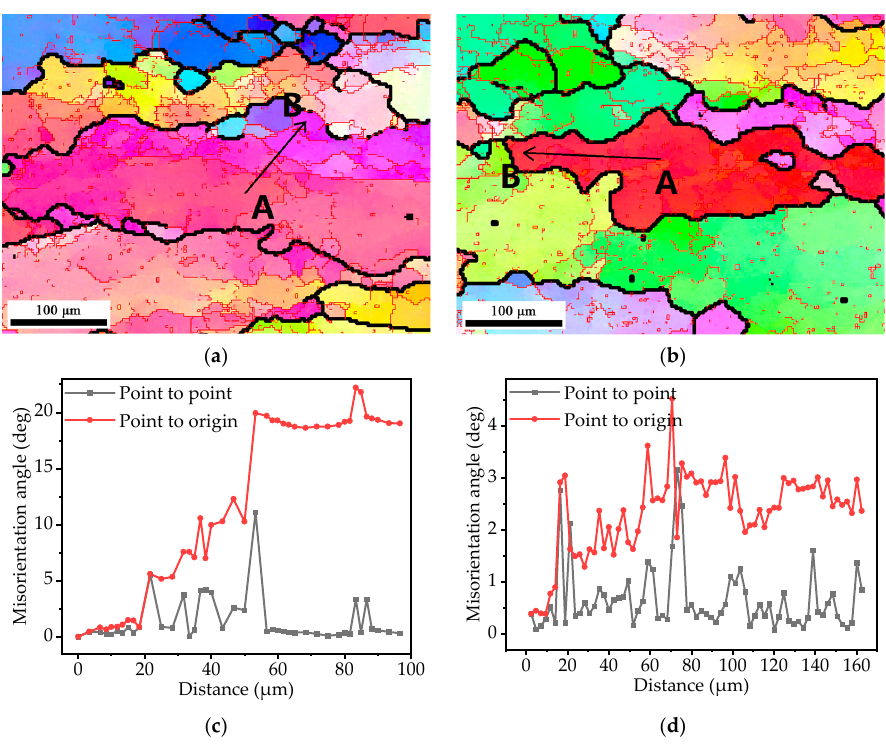
Figure 12. cDRX and dDRX of the Ti − 65541 alloy in region B: ( a , b ) EBSD map, ( c , d ) the map of misorientation.